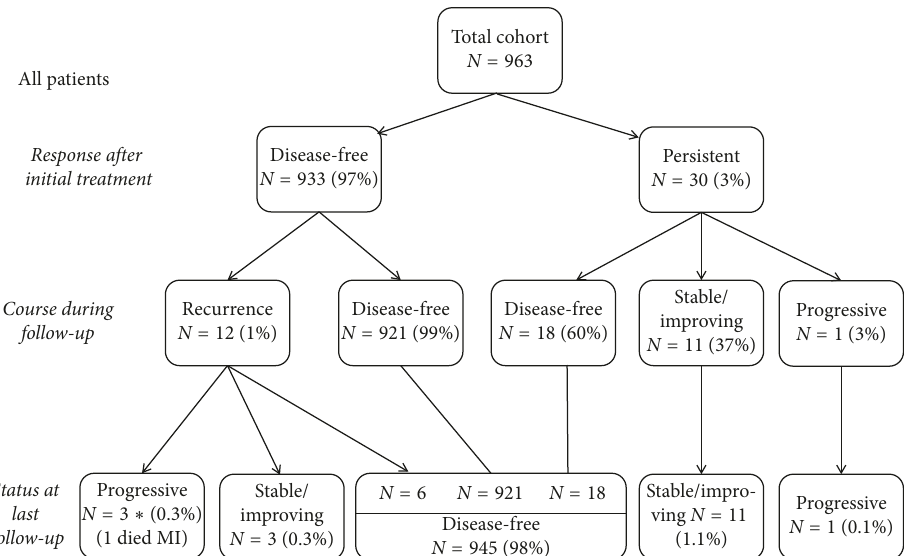
Figure 1: Flow chart demonstrating the stratification of all patients after initial therapy, during follow-up, and at last